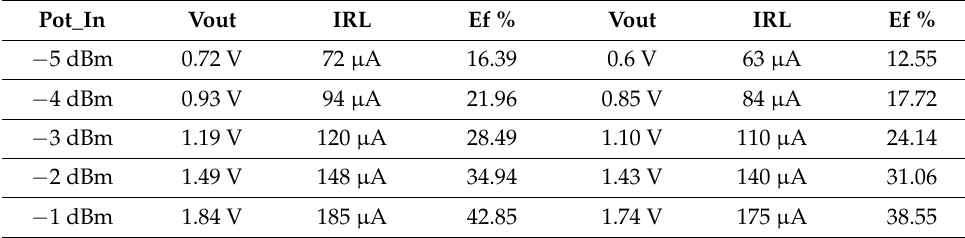
Table 6. Harvester efficiency for WiFi channels 1 and 6 RL